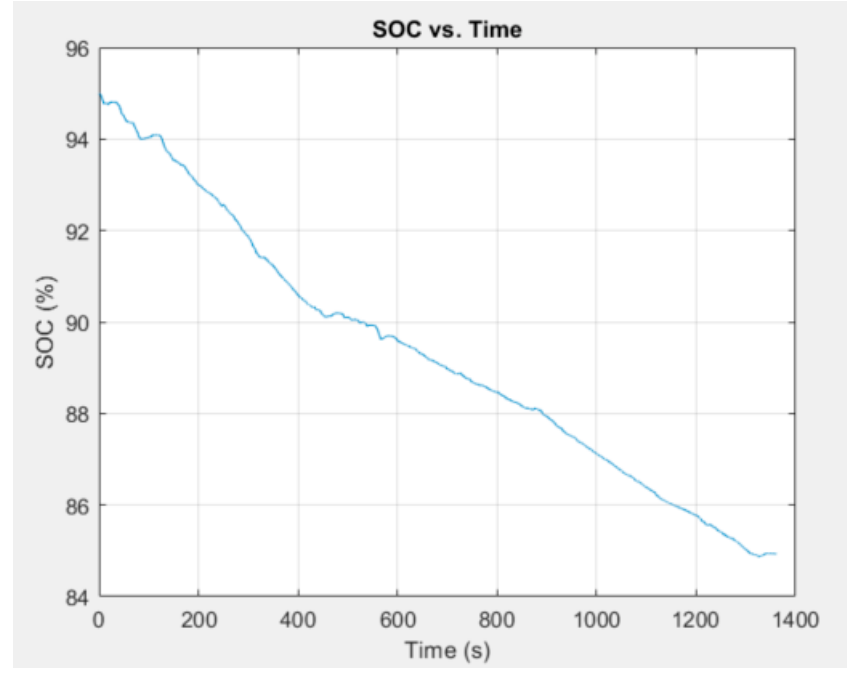
Figure 21. Modeled battery SOC over time.